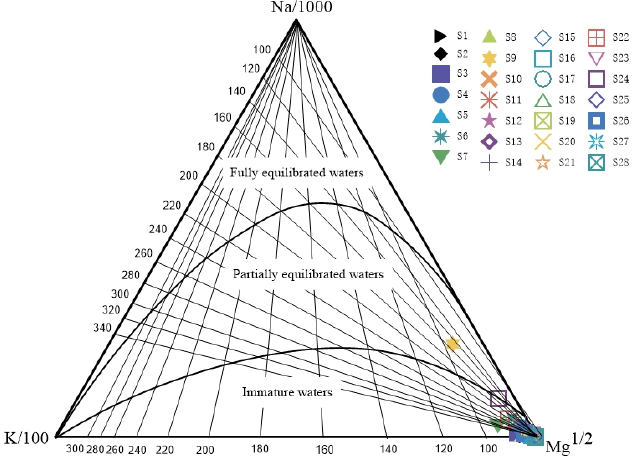
Figure 6. Distribution of aqueous samples on the Na/1000-K/100-Mg 1/2 ternary